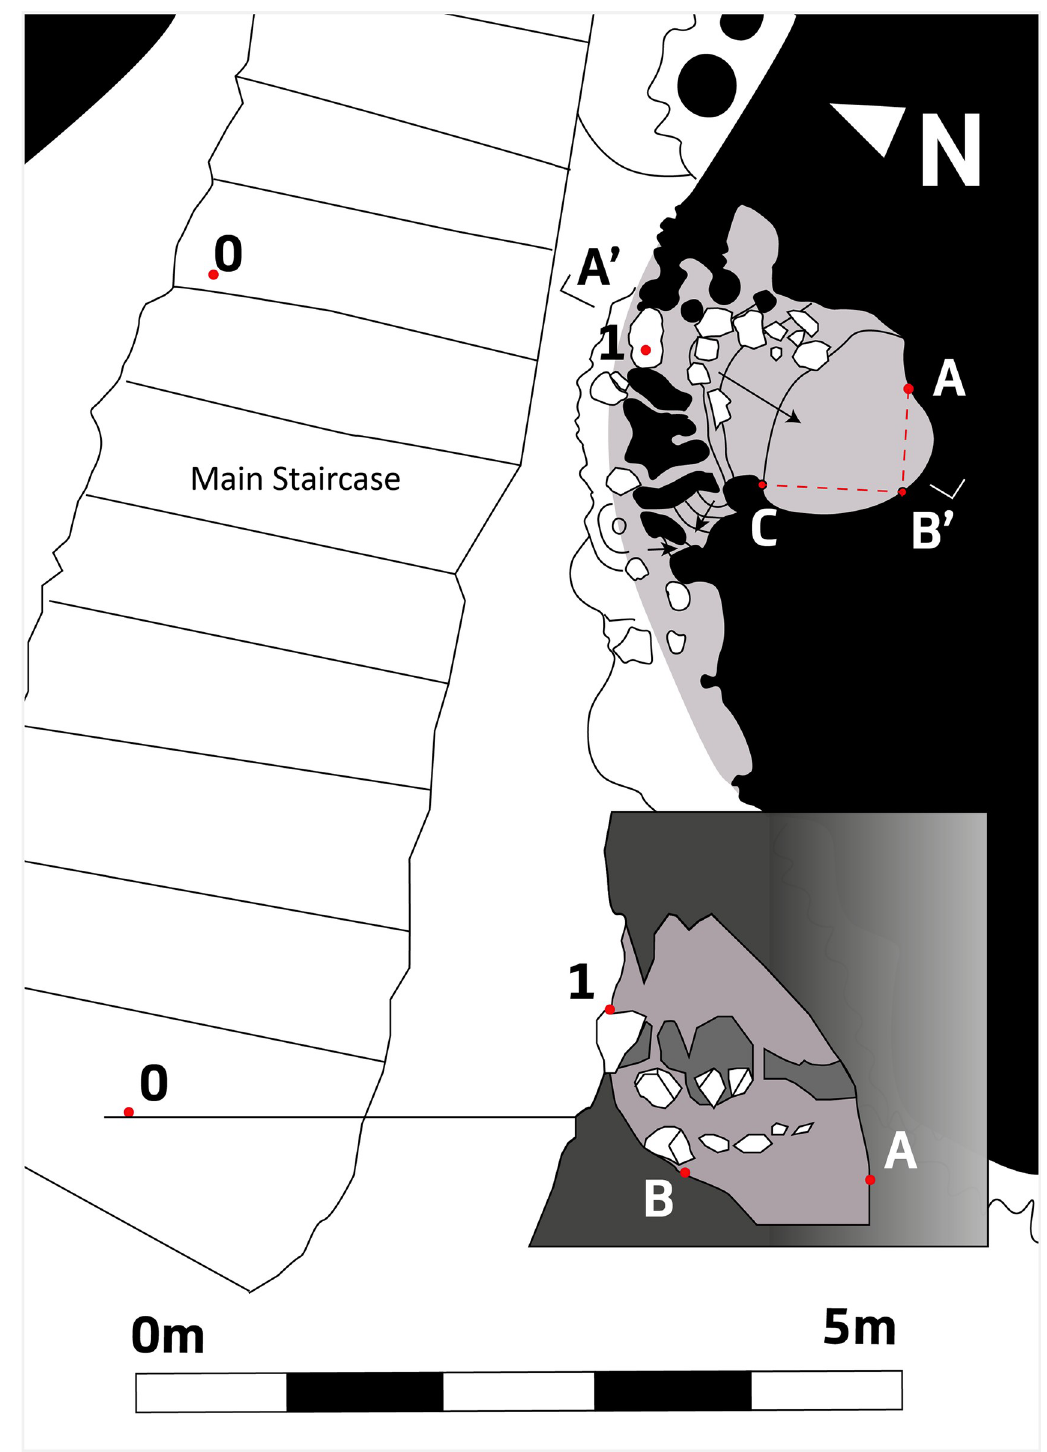
Fig 3. Location of a niche with human remains in speleothem pillars along the main stair case.